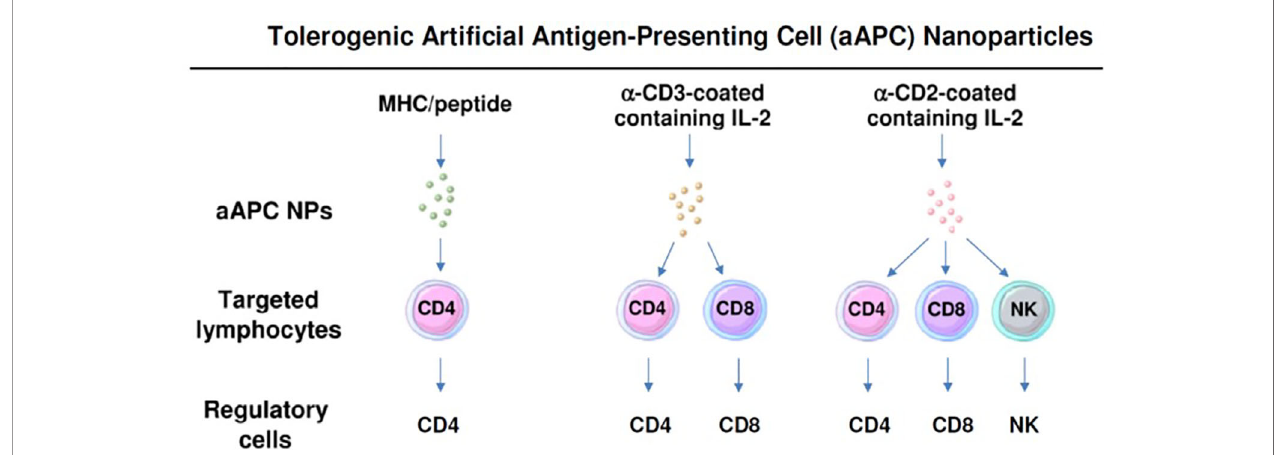
FIGURE 3 | Nanoparticles can be formulated as tolerogenic arti fi cial antigen-presenting cells that directly target speci fi c lymphocyte subpopulations to become regulatory cells. Three examples are shown that induce one or more subsets of regulatory